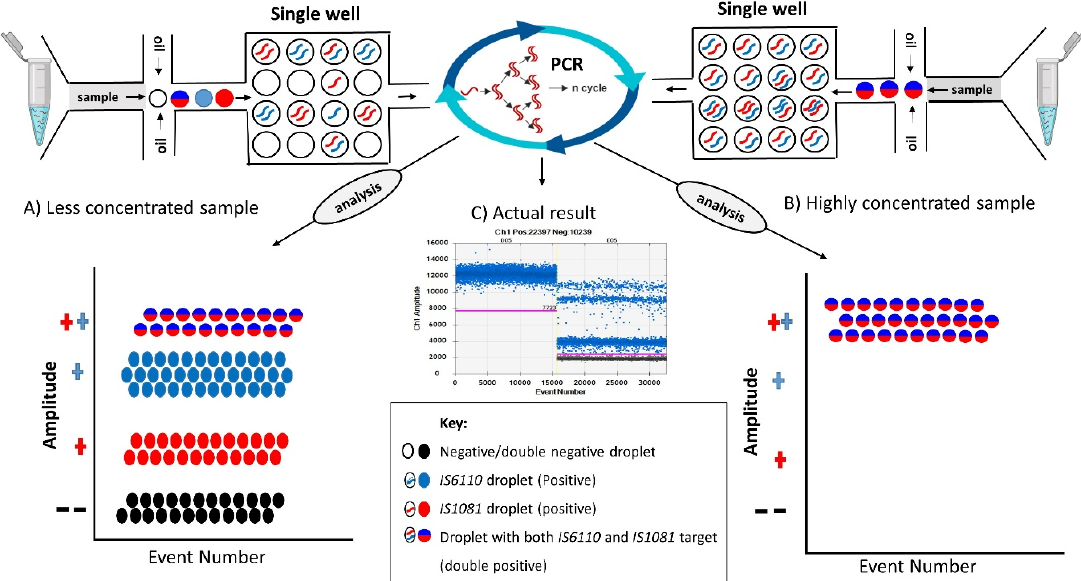
Figure 8. Droplet separation in a single dye duplex ddPCR assay based on sample concentration. ( A ) Less concentrated samples; droplets are generated and distributed randomly with some droplets containing only a single target (positive droplets), double targets (double positive droplets), and no targets (double negative droplets). After PCR amplification, the distribution of droplets gives four clear partitions where targets can be clearly identified. ( B ) Highly concentrated samples; each droplet generated here has both targets in a single droplet, meaning all the droplets generated are double positive droplets. PCR amplification will consequently result in highly concentrated double positive droplets that during analysis and reading will exhibit double fluorescence, which automatically results in a single double positive droplet partition.